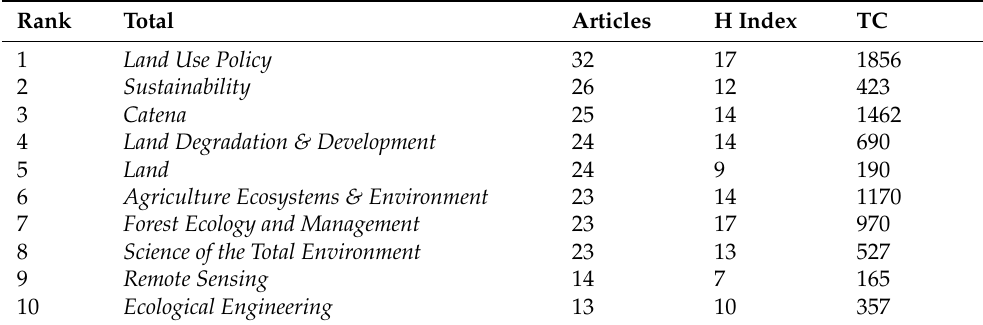
Table 1. Journal sources with the most published articles on farmland abandonment from 1980 to 2021 (Note: TC = total citations).